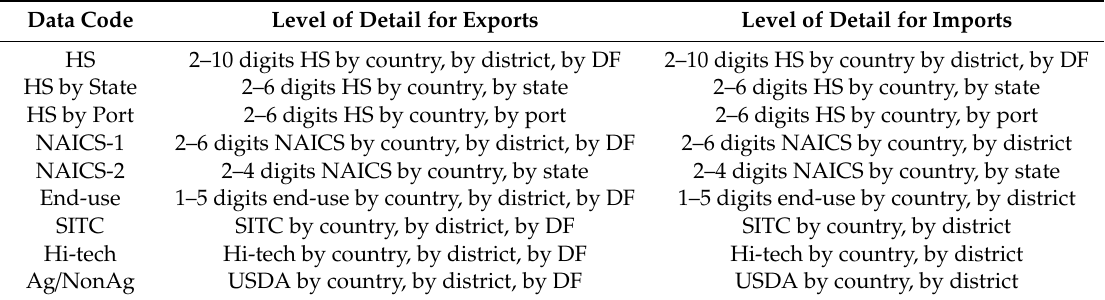
Table 2. Common commodity and industry classifications and